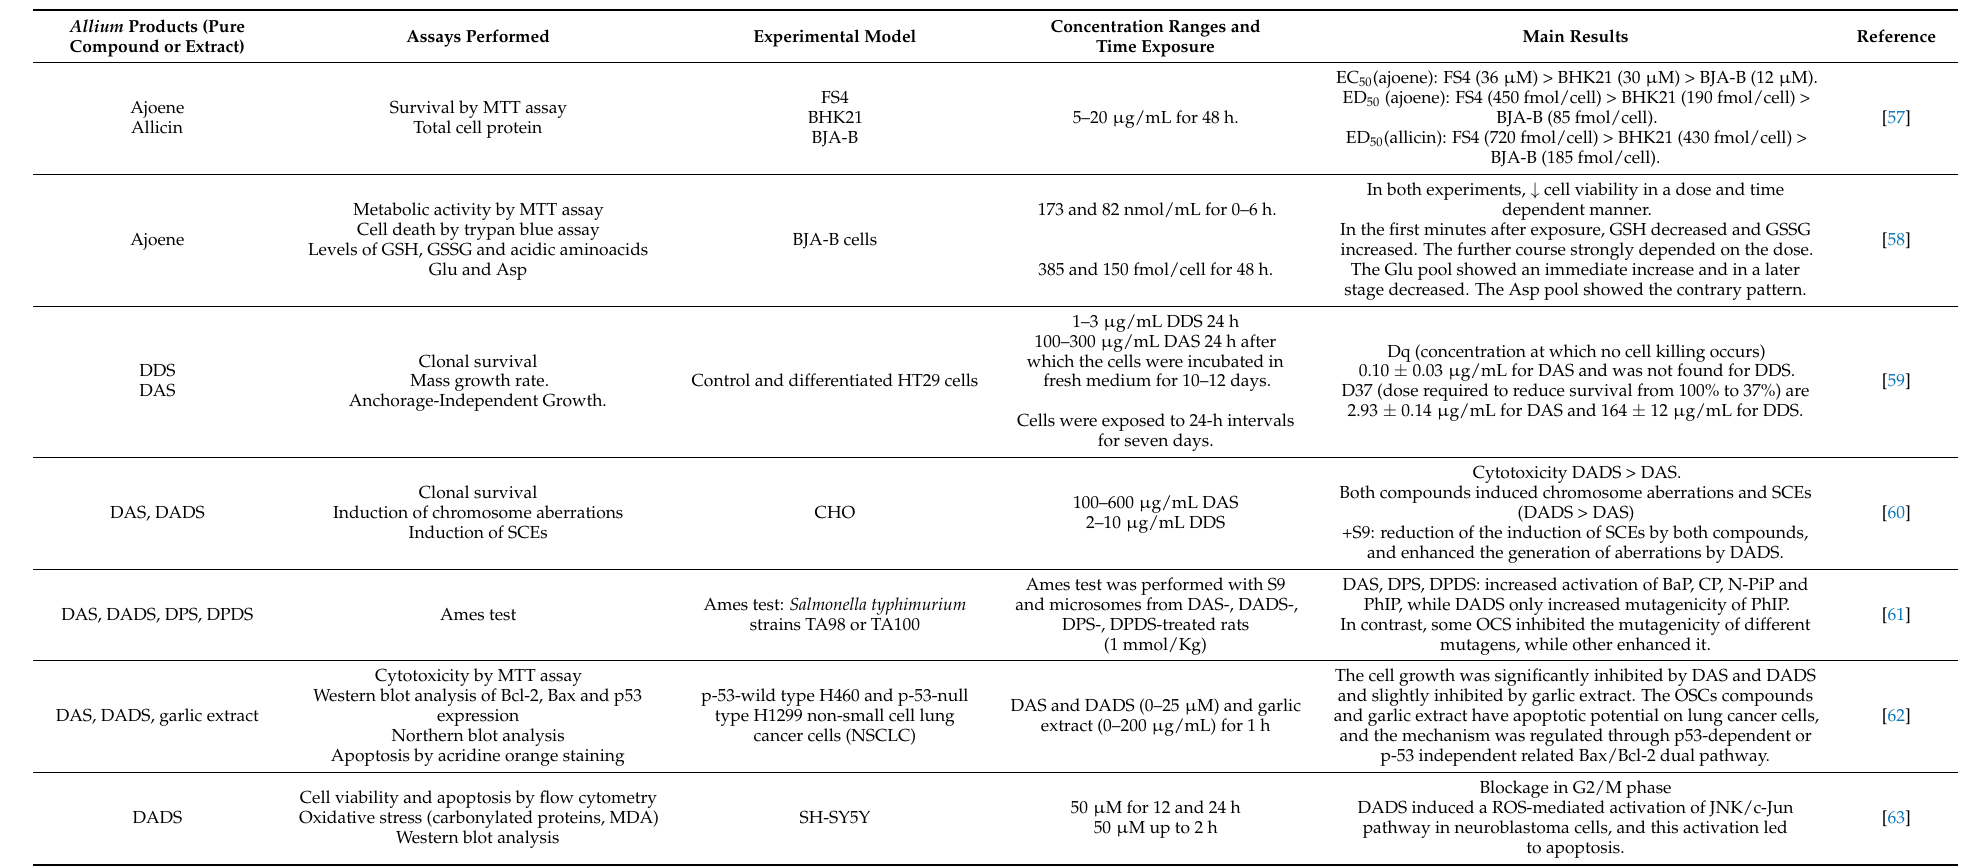
Table 2. Overview of the studies reporting the in vitro toxicological evaluation of OSCs from Allium